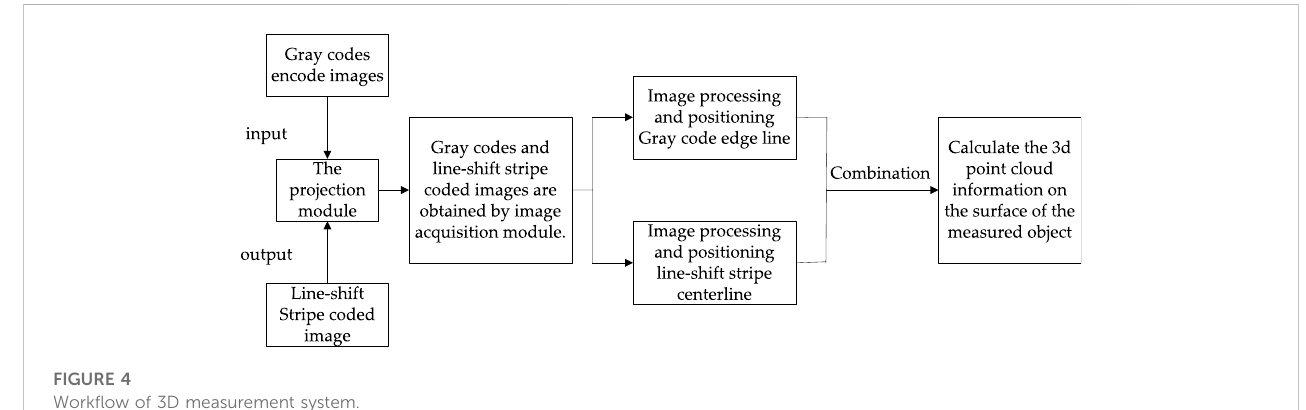
Figure 5A isastandardgray codeimage. Projectingitontothesurface of the object to be measured, we get the image shown in Figure 5B.